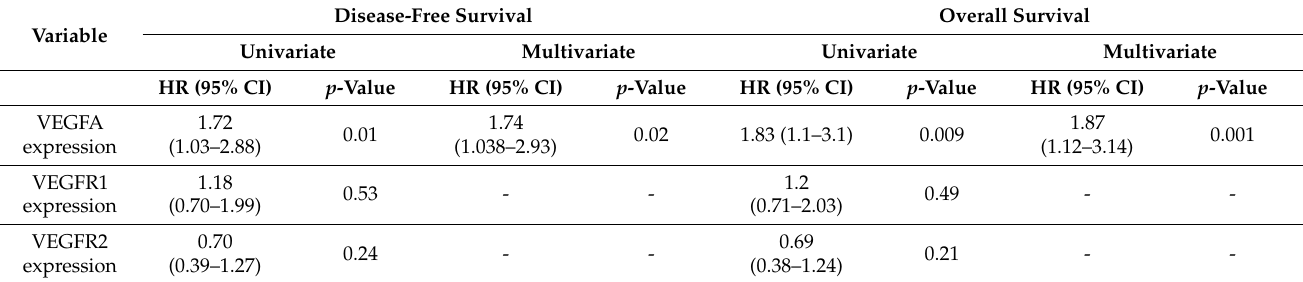
Table 4. Univariate and multivariate Cox regression results for the associations between VEGFA, VEGFR1, and VEGFR2 expressions and disease-free survival (DFS) and overall survival (OS) for